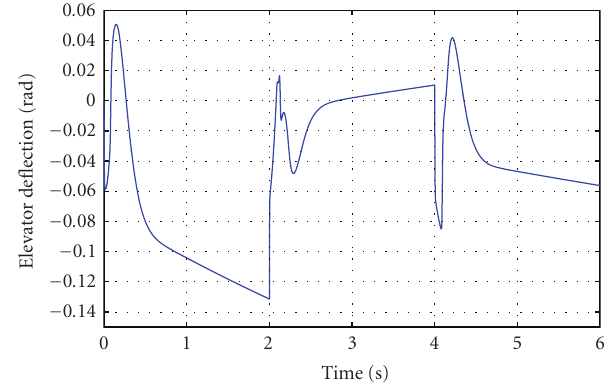
Figure 3: Elevator deflection versus time.